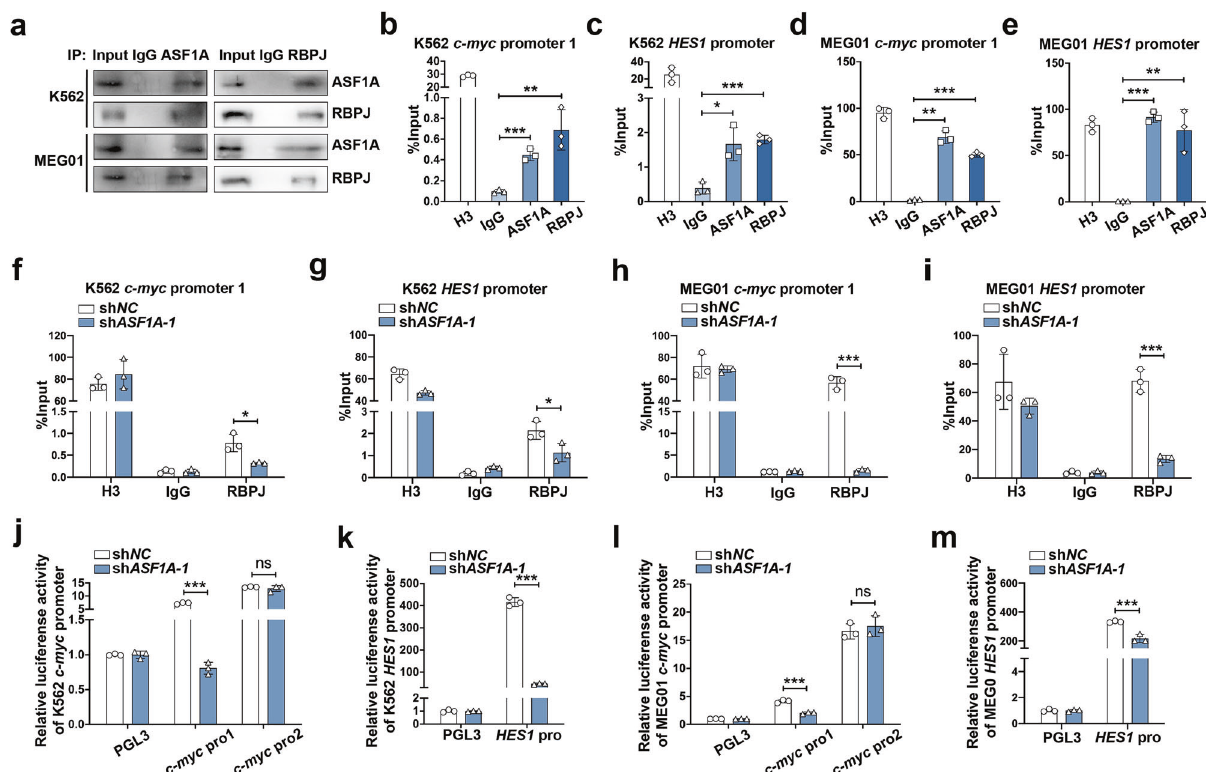
Fig. 5 ASF1A cooperates with RBPJ activates Notch signaling. a Co-immunoprecipitation analysis of the interaction between ASF1A and RBPJ in K562 and MEG01 cells. b – e Enrichment of ASF1A and RBPJ at c-Myc ( b , d ) and HES1 ( c , e ) promoters in K562 and MEG01 cells. f – i RBPJ enrichment at c-Myc ( f , h ) and HES1 ( g , i ) promoters in K562 and MEG01 cells expressing empty vector (sh NC ) or sh ASF1A-1 . Histone H3 and IgG antibodies were used as positive and negative controls, respectively. j – m Luciferase activity analysis of c-Myc ( j , l ) and HES1 ( k , m ) activation in K562 and MEG01 cells transfected with empty vector (sh NC ) or sh ASF1A-1 . Luciferase activity was determined 48 hours after transfection, and normalized according to Renilla luciferase activity. P values in b – e were determined by one-way ANOVA, and P values in f – m were calculated using Student ’ s t test. Data are shown as mean ± standard deviation (SD). Data are shown as a representative result with three repeats from three independent experiments. The cell lines are applied with three independent lentiviral infections in b – m . * P < 0.05, ** P < 0.01, *** P <